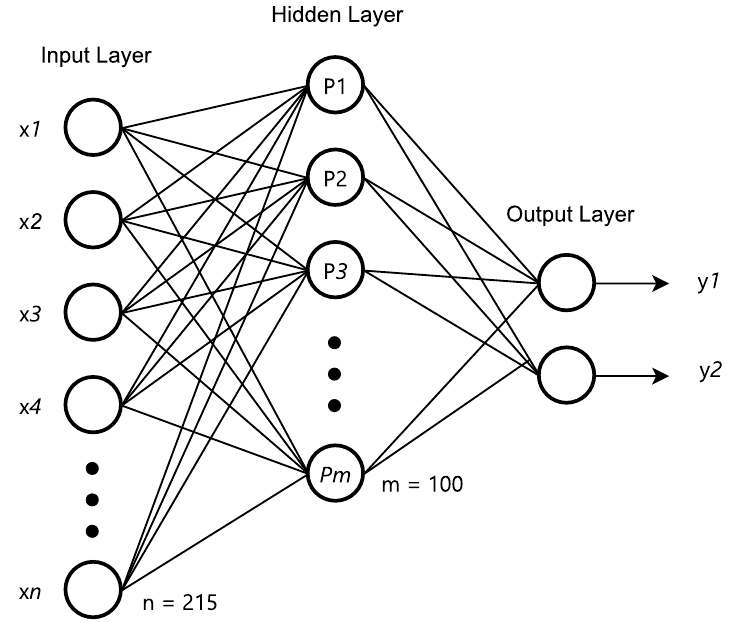
Figure 3. Proposed MLP schematic